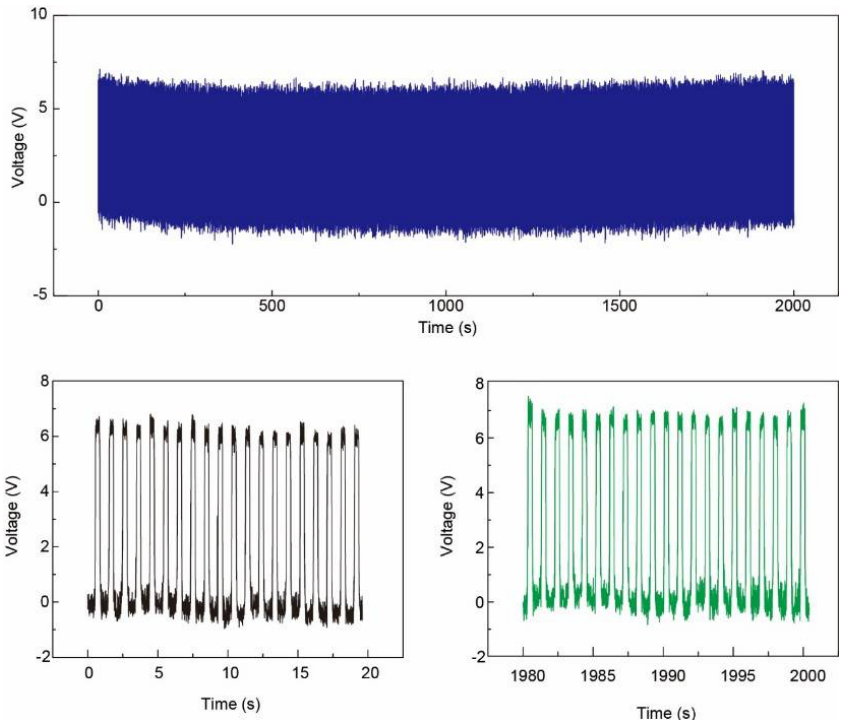
Figure 7. Top : output voltage for 2000 s (~2000 circles) to show the stability of the patterned Ag NFs electrode based pressure sensor array. Bottom : output voltage of the beginning and the end of the test. The output voltage from one fixed pixel kept between 6–7 V.